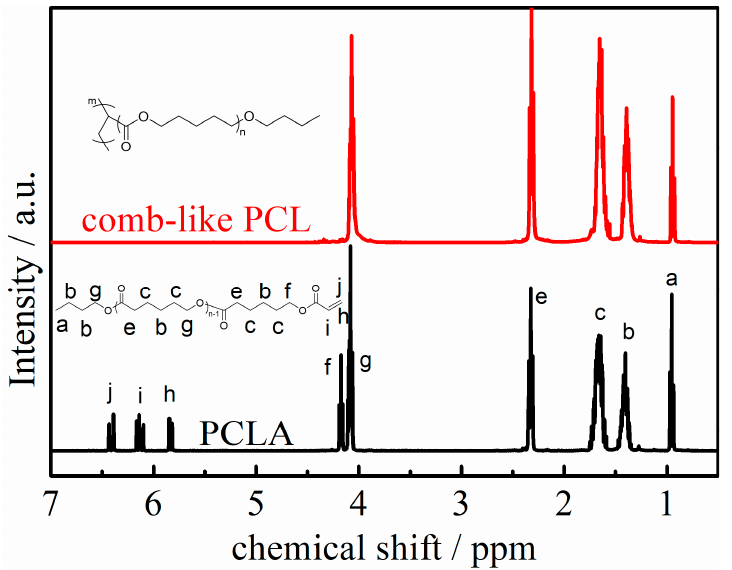
Figure 1. The 1 H NMR results of the PCLA precursor and comb ‐ like PCL in CDCl 3 .